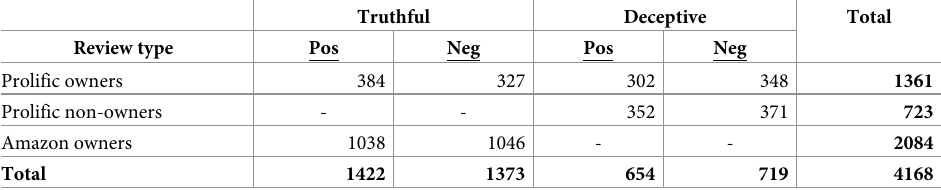
Table 2. Overview of all filtered